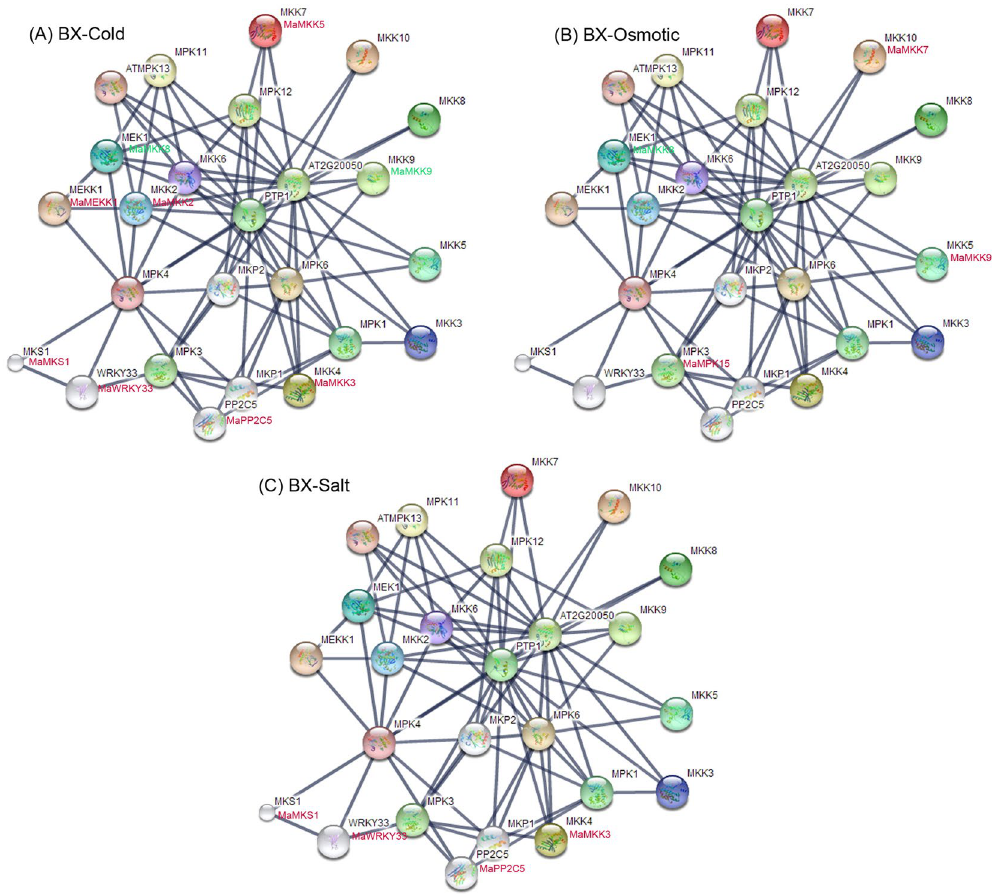
Figure 12. Interaction network and co-expression analyses of banana MAPKKK-MAPKK-MAPK cascades after cold, osmotic and salt treatments in BX and related genes in Arabidopsis. The homologous genes of banana are in parentheses. The genes marked with red show significant upregulation (Log2 based FPKM value > 1 and P -value < 0.05). The genes marked with green show significant downregulation (Log2 based FPKM value < − 1 and P -value <